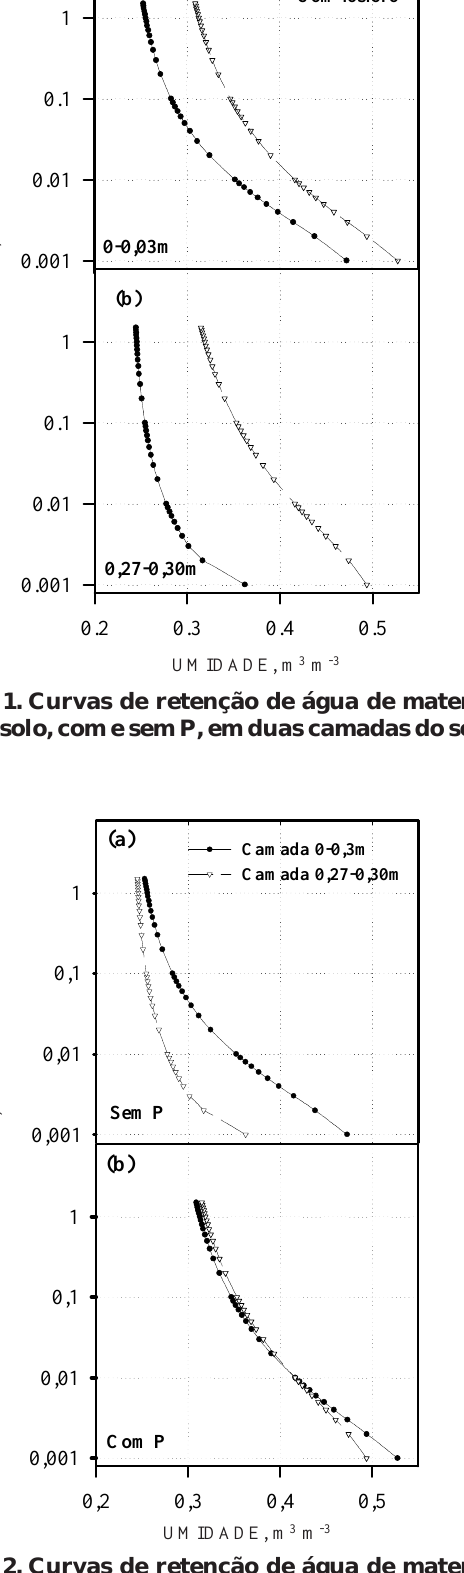
Figura 2. Curvas de retenção de água de material de solo, com e sem P, em duas camadas do solo.